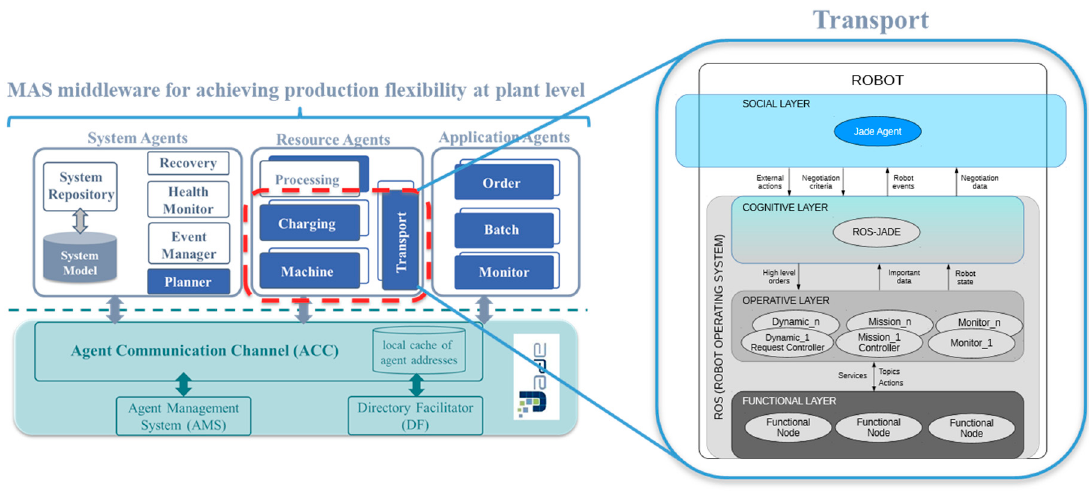
Figure 7. The architecture of the MAS middleware for achieving production flexibility at plant level and its relation to the ROS-JADE integration architecture.